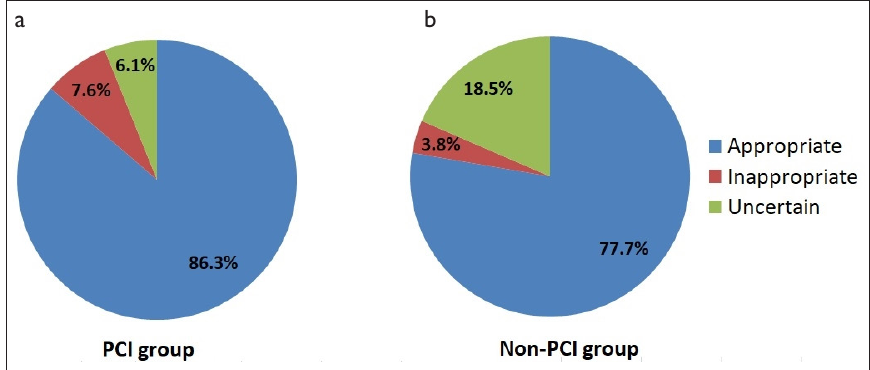
Figure 1. a, b. (a) PCI appropriateness in PCI group and (b) non-PCI group. PCI, percutaneous coronary